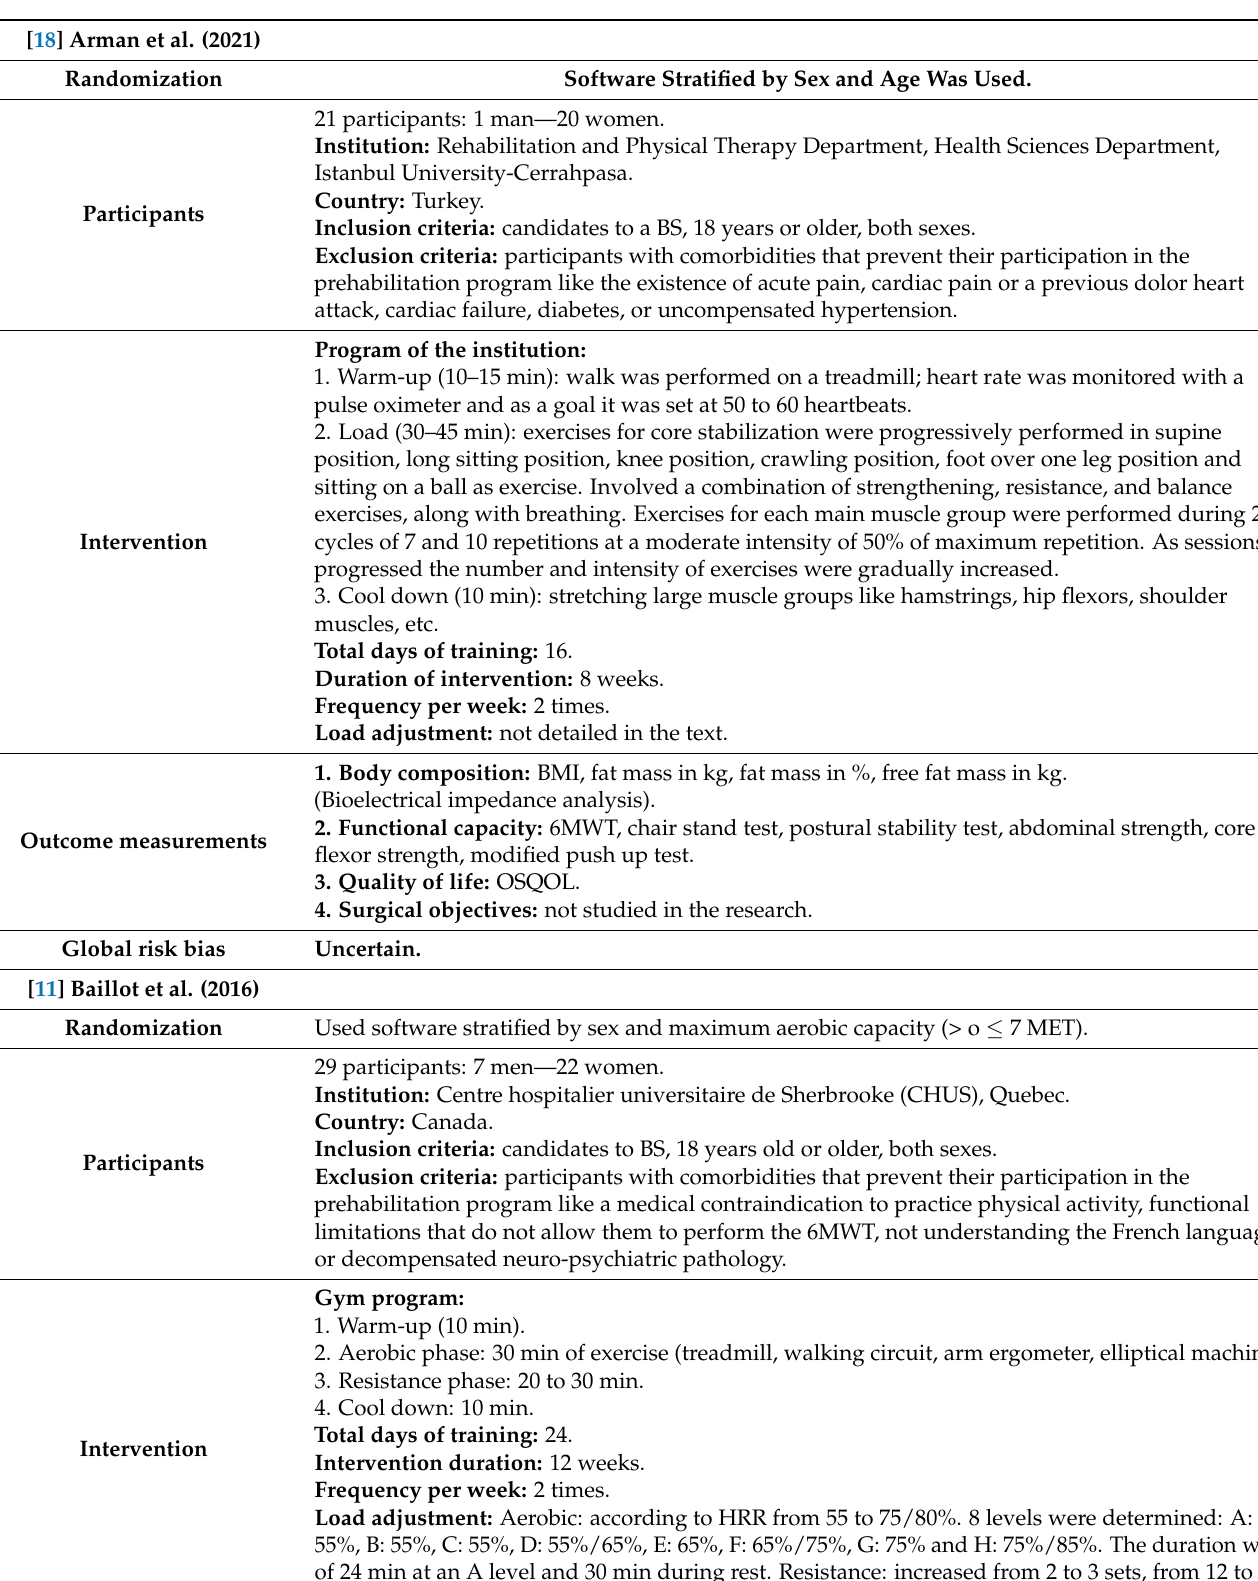
Table 1. Description of each